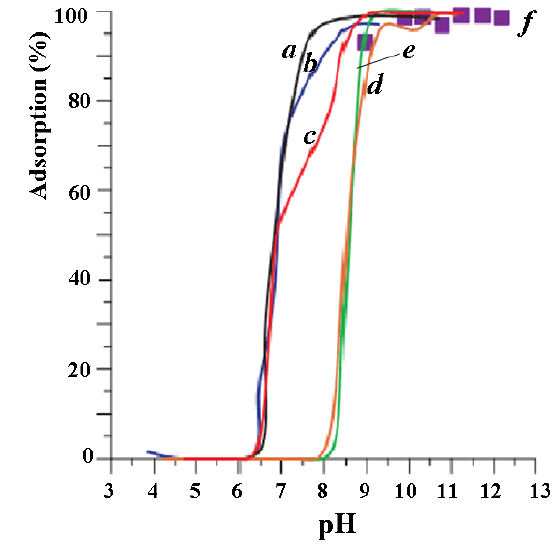
Figure 5. Isotherms of Zn(II) ions adsorption for different TiO amorphous (a), anatase (b), rutile (c), anatase+rutile (d), anatase+brookite (e), brookite (f).